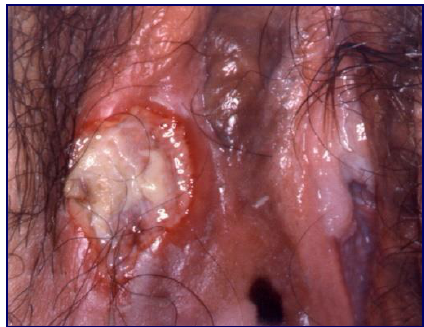
Figure 20. Behçet’s disease.